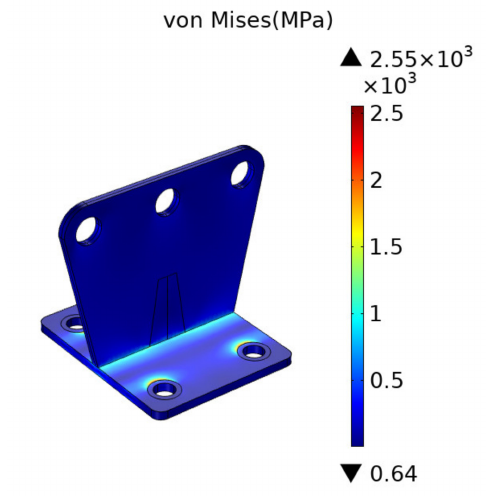
Figure 4. Von-Mises stress distribution of the original